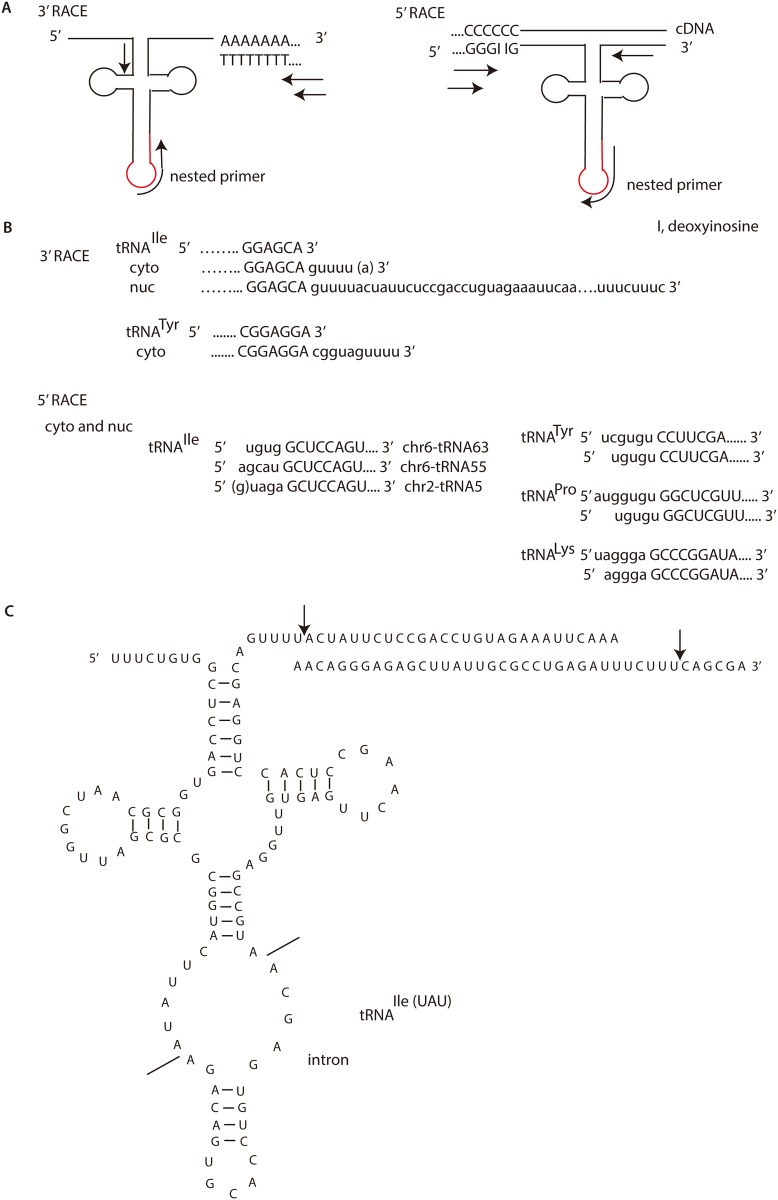
3’ rapid amplification of cDNA ends (RACE) and 5’ RACE analysis.(A) Schematic diagram of strategy for 3’ RACE (left panel) and 5’ RACE (right panel). Red curve represents the intron of pre-tRNAIle(UAU). (B) Results of 3’ RACE and 5’ RACE of pre-tRNAIle(UAU), pre-tRNALys, pre-tRNAPro, pre-tRNATyr from the nucleus (nuc) and the cytoplasm (cyto). 5’ leaders or 3’ trailers are in small letters. (C) The secondary structure of the intron-containing tRNAIle(UAU) (Chr6-tRNA63) with the long 3’ trailer.